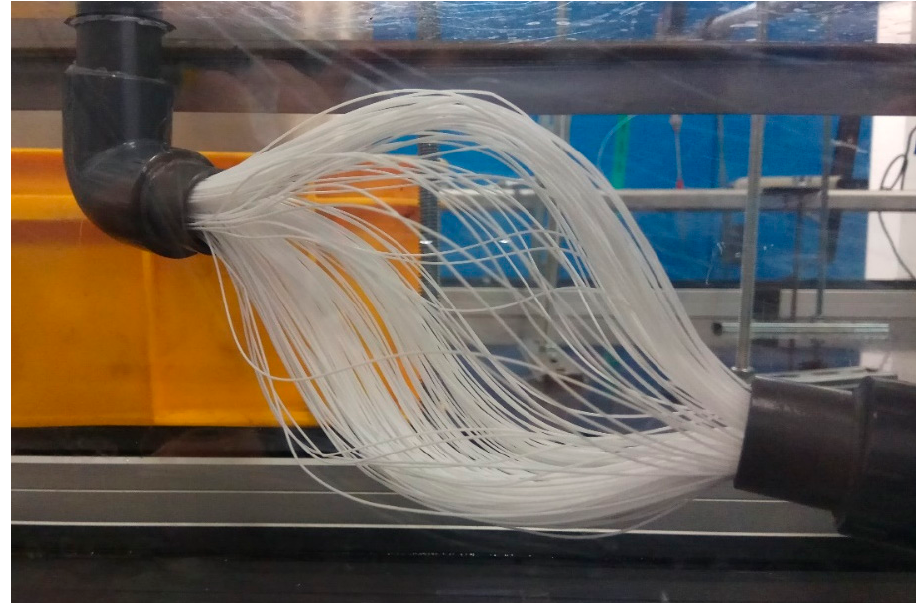
Figure 7. MM002 during experiment. Table 10. Measured temperatures and humidity for MM002. Table 11. Thermal performance, measurement error, condensate amount, permeate flux, and membrane module pressure drop for